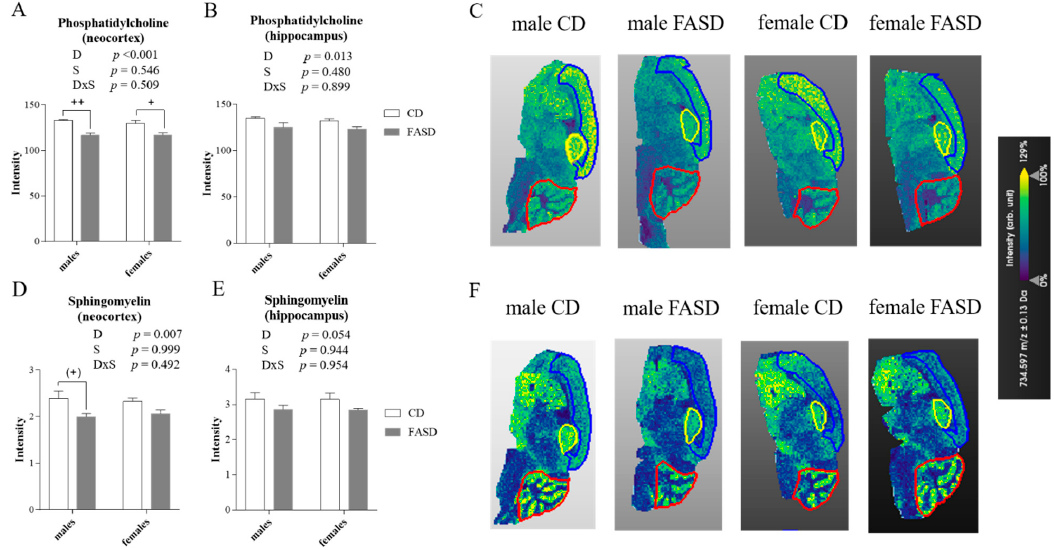
Figure 6. PtdCho and SM measured by MALDI-IMS in offspring brain. ( A ) The two most abundant species of PtdCho (m/z 734 + 760) were decreased in neocortex of FASD pups. ( B ) These 2 species were also decreased in hippocampus of FASD pups ( C ) Representative mapping of the different signal intensities (arbitrary units) for PtdCho (m/z 734) in neocortex (designated by a blue line), hippocampus (yellow line), and cerebellum (red line). ( D ) SM was decreased due to FASD in neocortex, predominantly in males. ( E ) SM was decreased due to FASD in hippocampus although this change was not statistically significant. ( F ) Representative mapping of the different signal intensities (arbitrary units) for SM in neocortex (designated by a blue line), hippocampus (yellow